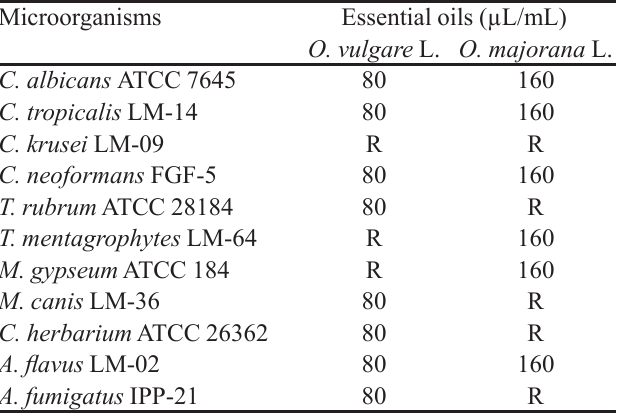
TABLE II - MIC of the essential oil from O. vulgare L. and O. majorana L. against some potentially pathogenic fungi* Microorganisms